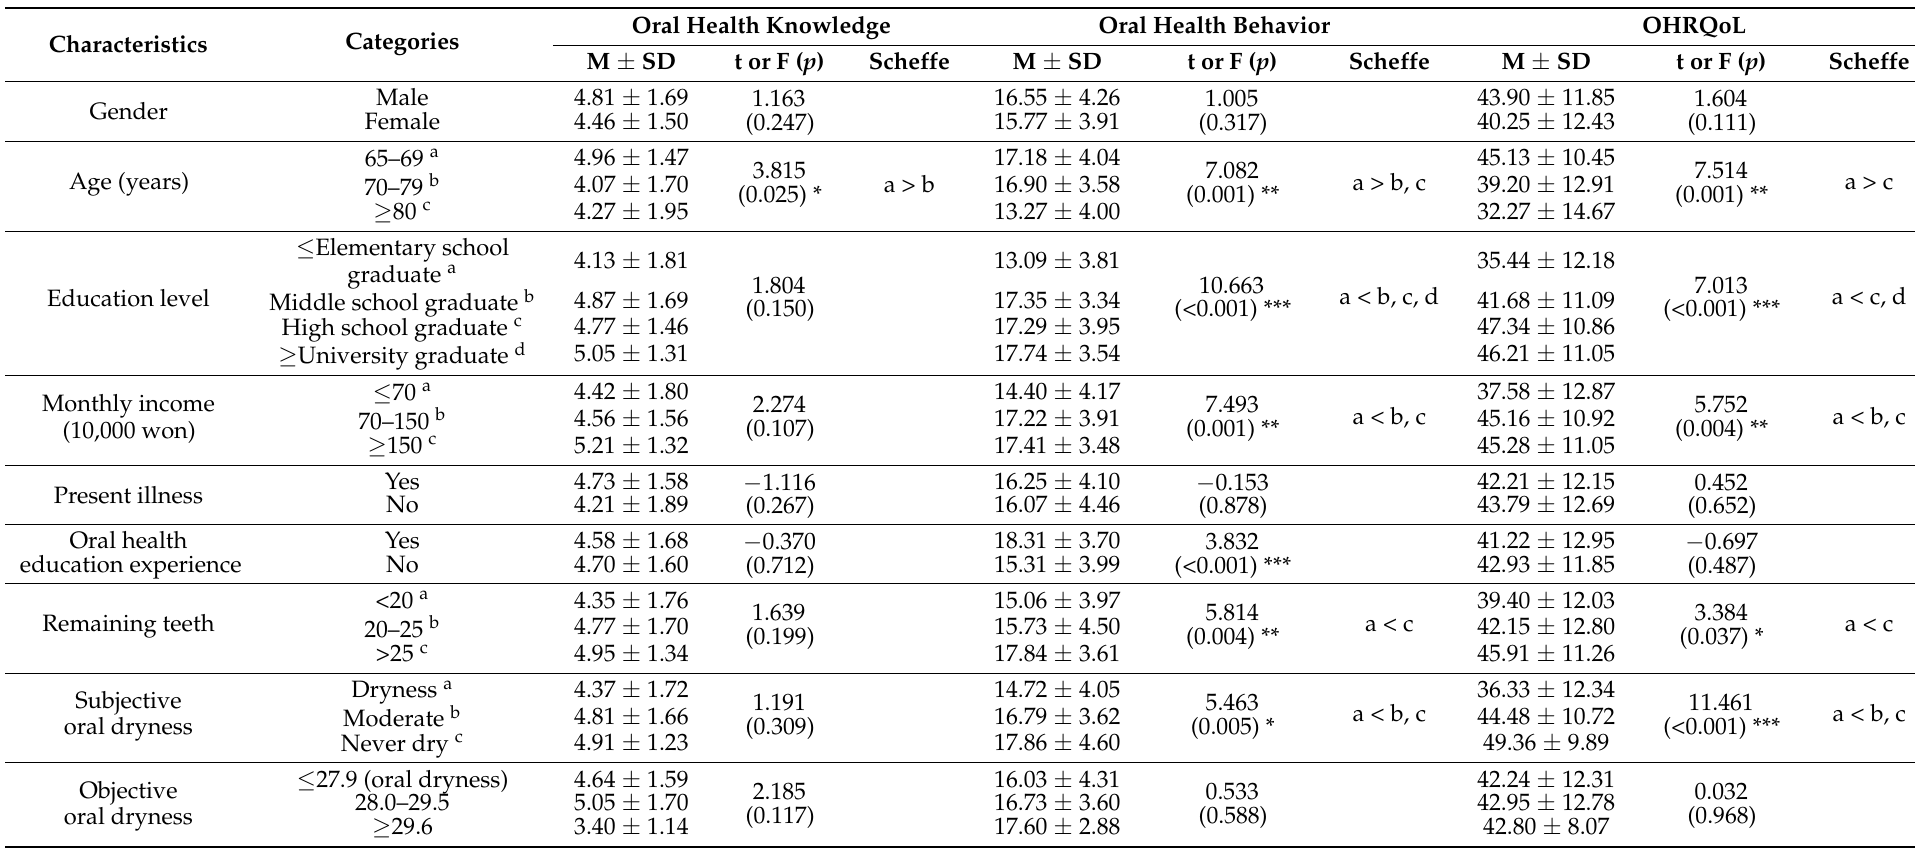
Table 2. Oral health knowledge and behavior and oral health-related quality of life (OHRQoL), according to general and oral health characteristics ( n =